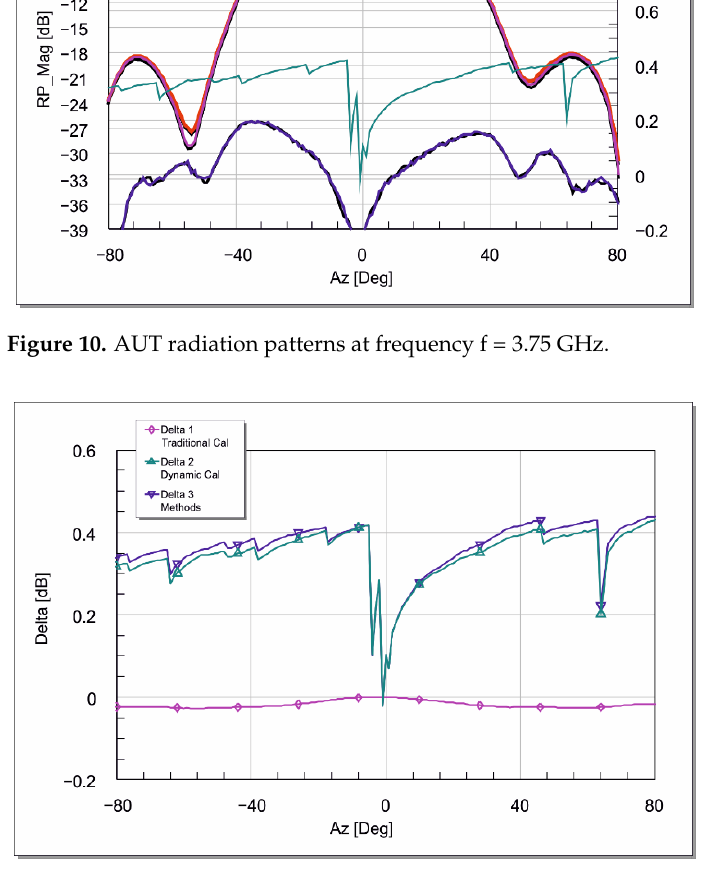
Figure 10. AUT radiation patterns at frequency f = 3.75 GHz.